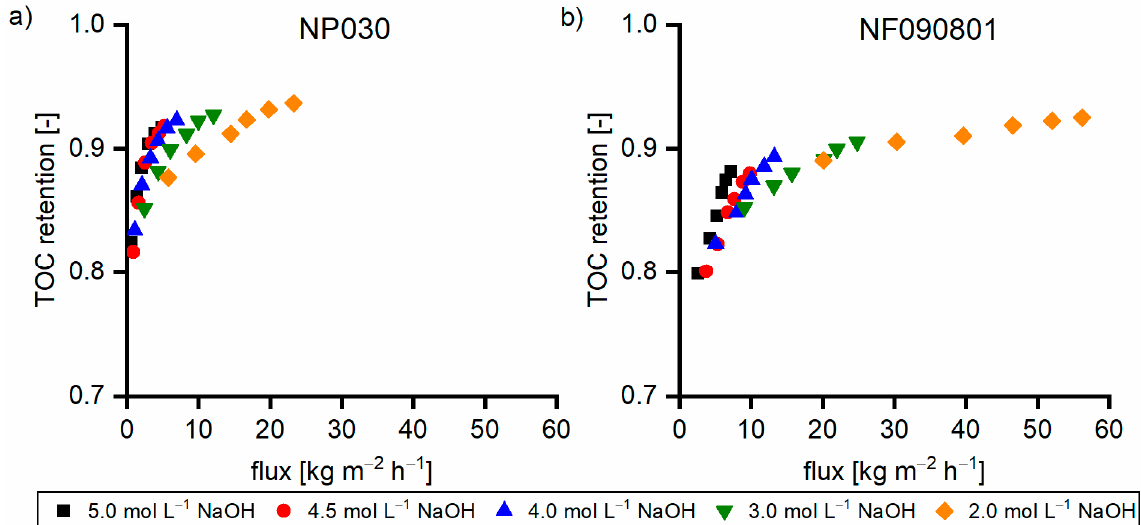
Figure 10. TOC retention of Sol5 with various dilution rates with water for ( a ) NP030 and ( b ) NF090801.